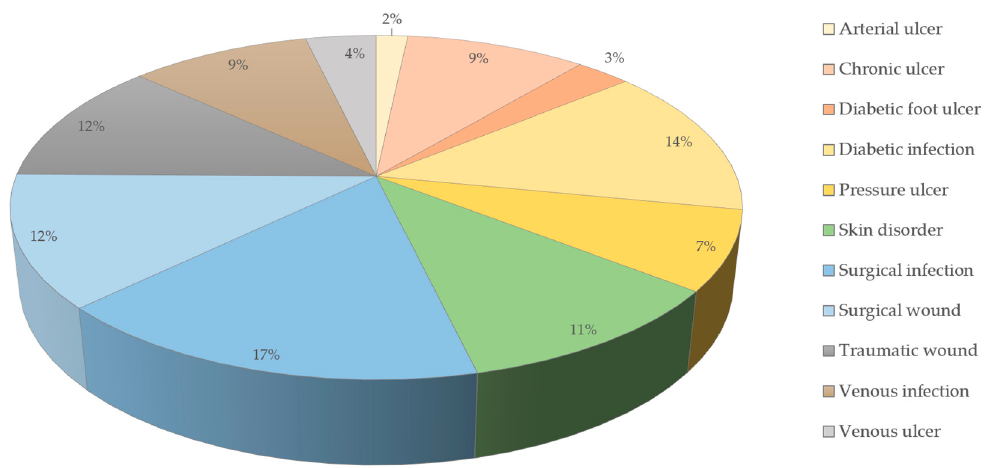
Figure 1. Prevalence of wound types in the Medicare population (data from the year 2014) [25].